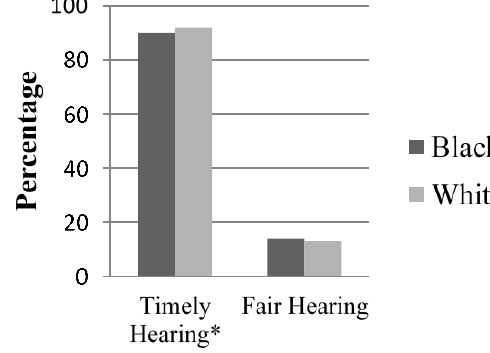
Figure 1. TennCare Appellate Hearings by Race.